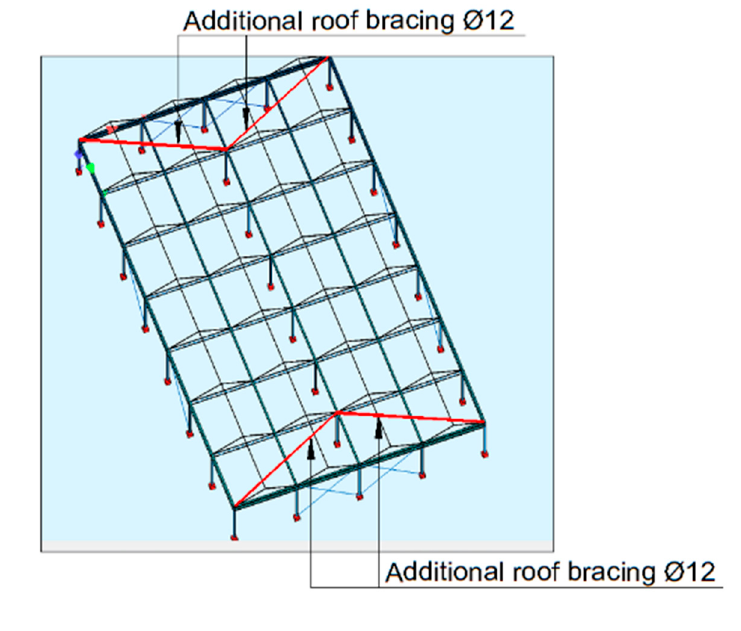
Figure 20. Additional roof bracing to decrease horizontal displacement. Table 9. Utilization ratios of the two greenhouses after strengthening.